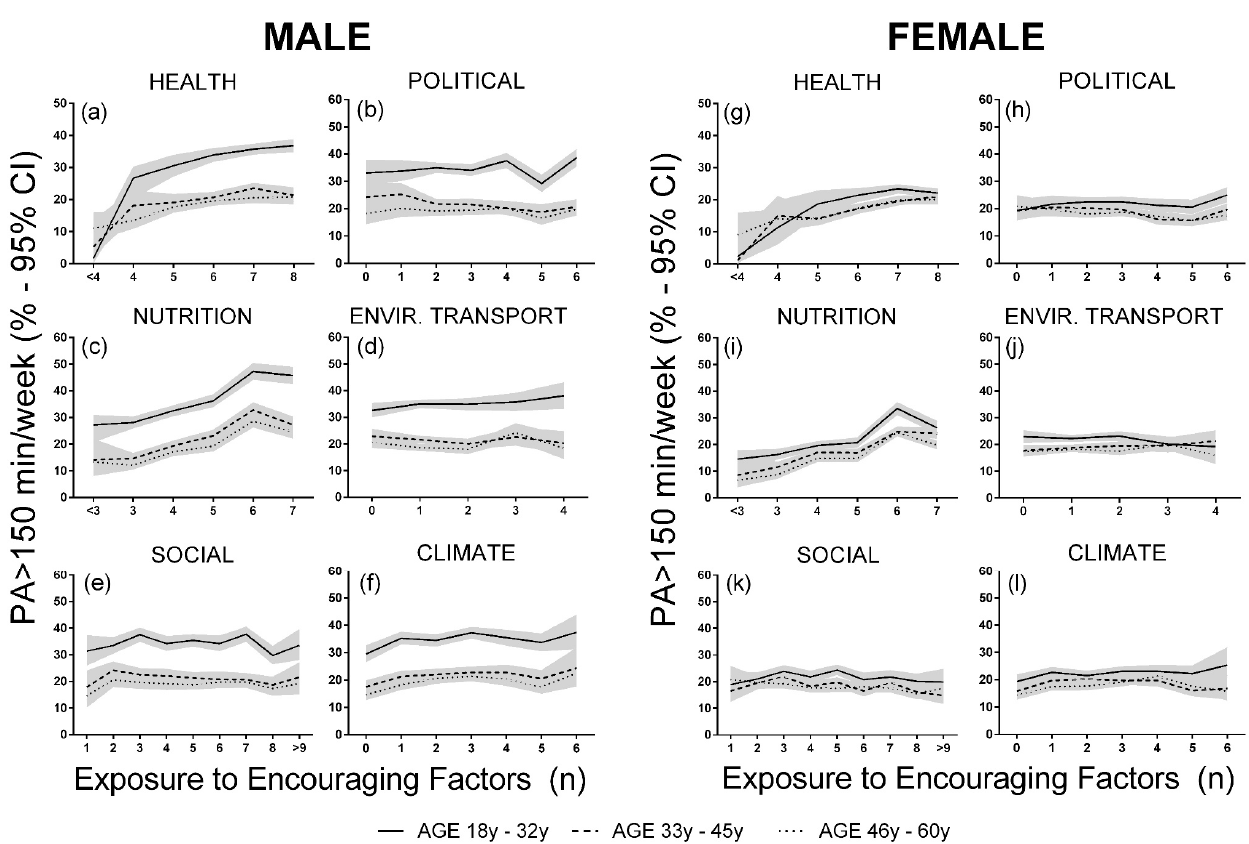
11 Figure 3. Exposure-response of social-ecological factors on the prevalence of physical activity (PA) > 150 min / week, adjusted by age and sex. ( a ) Exposure-response of health factors on the PA prevalence for men. ( b ) Exposure-response of political factors on the PA prevalence for men. ( c ) Exposure-response of nutrition factors on the PA prevalence for men. ( d ) Exposure-response of environment / transport factors on the PA prevalence for men. ( e ) Exposure-response of social factors on the PA prevalence for men. ( f ) Exposure-response of climate factors on the PA prevalence for men. ( g ) Exposure-response of health factors on the PA prevalence for woman. ( h ) Exposure-response of political factors on the PA prevalence for woman. ( i ) Exposure-response of nutrition factors on the PA prevalence for woman. ( j ) Exposure-response of environment / transport factors on the PA prevalence for woman. ( k ) Exposure-response of social factors on the PA prevalence for woman. ( l ) Exposure-response of climate factors on the PA prevalence for woman. Solid line represents subgroup aged 18–32 years; dashed line represent subgroup aged 33–45 years; dotted line represents subgroup aged 46–60